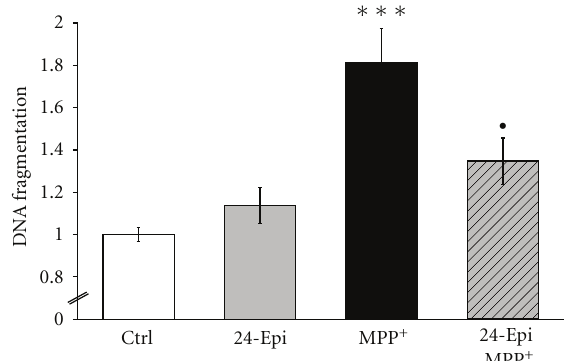
Figure 6: Detection of DNA fragmentation in apoptotic cells with monoclonal antibody to ssDNA. Cells were pretreated with 24- Epi or vehicle (Ctrl) for 3h. Then, they were treated or not with MPP + for 24h. PC12 cells pretreated with vehicle and exposed to MPP + for 24h (MPP + ) revealed a significant increase in DNA fragmentationcompared to the control (vehicle).Pretreatment with 24-Epi and treatment with MPP + (24-Epi + MPP + ) significantly decreased DNA fragmentation compared to the MPP + condition. The data are expressed as percentages of values in untreated control cells and are means ± S.E.M. n = 3. ∗∗∗ P < . 001 versus Ctrl and • P < . 05 versus MPP + .